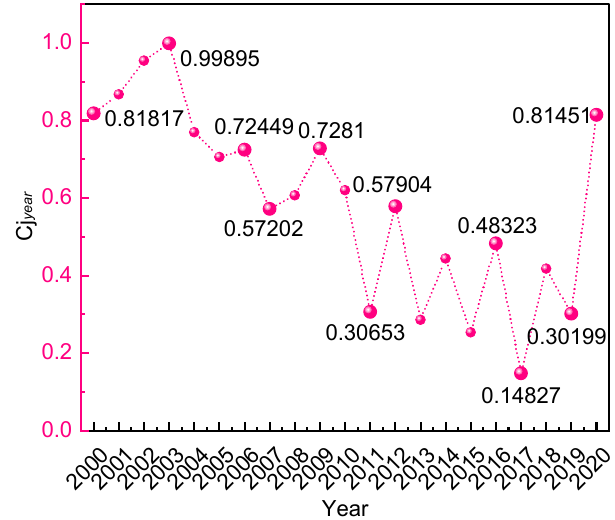
Table 7. Values and ranking of monthly systematic risk factor.